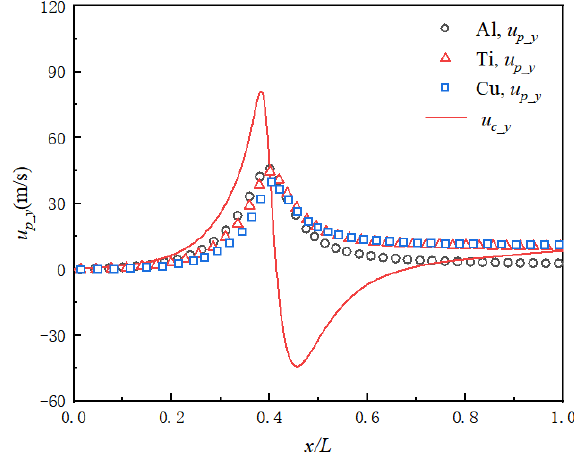
Figure 9. Velocity in the y -direction of the particle released from the same initial position with variable densities.